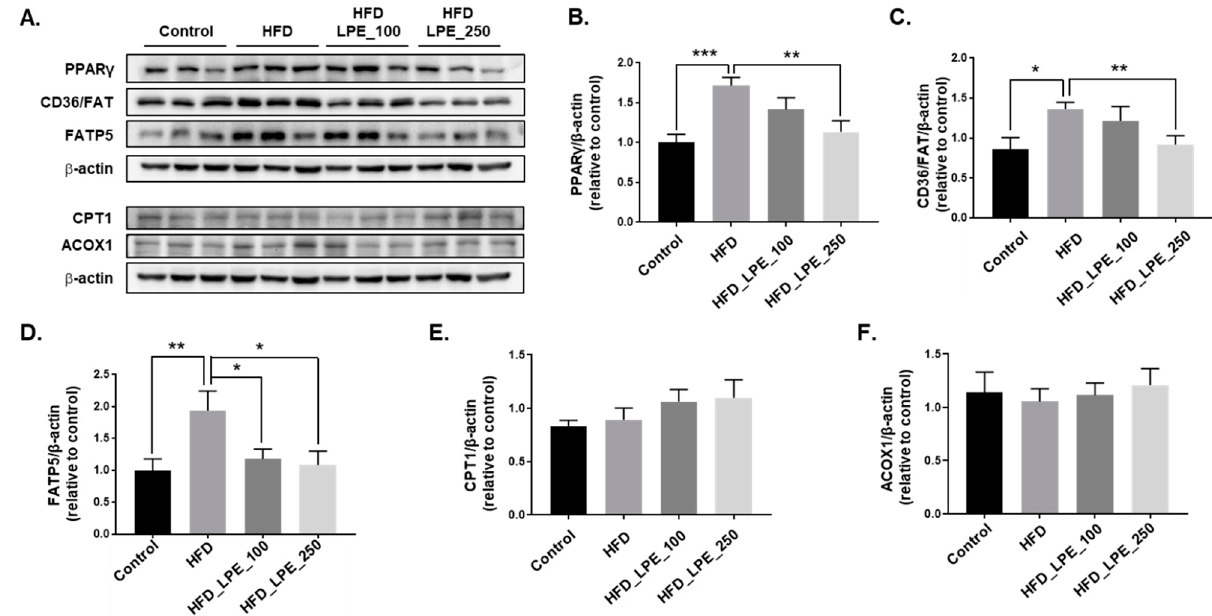
Figure 4. LPE treatment decreased the expression of proteins involved in fatty acid uptake in HFD-fed mice. PPAR γ , CD36/FAT, FATP5, CPT1, and ACOX1 protein expressions were analyzed by Western blotting. Beta-actin was used as the loading control for equal amounts of protein. ( A ) Representative immunoblots of PPAR γ , CD36/FAT, FATP5, CPT1, and ACOX1, together with β -actin, and the relative intensity levels of ( B ) PPAR γ , ( C ) CD36/FAT, ( D ) FATP5, ( E ) CPT1, and ( F ) ACOX1, were normalized to beta-actin. Data are shown as mean ± SEM, n = 6–11/group. * p < 0.05, ** p < 0.01, or *** p < 0.001. One-way ANOVA was performed along with Fisher’s protected least significant difference test.